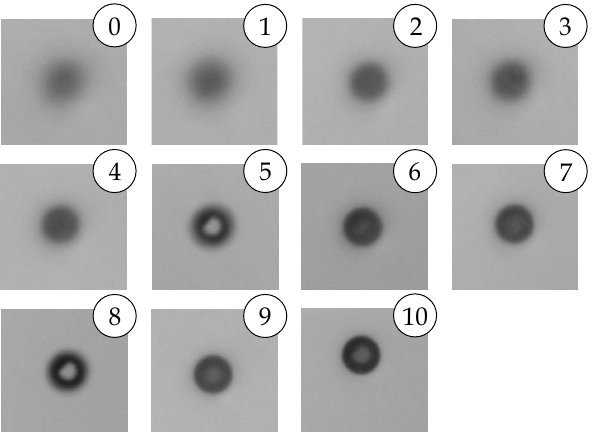
Figure 6. Eleven different particles were captured by C 2 with a THV = 62, each with different acceptable ESV between 0–10. Associated results based on ESV are shown in Table